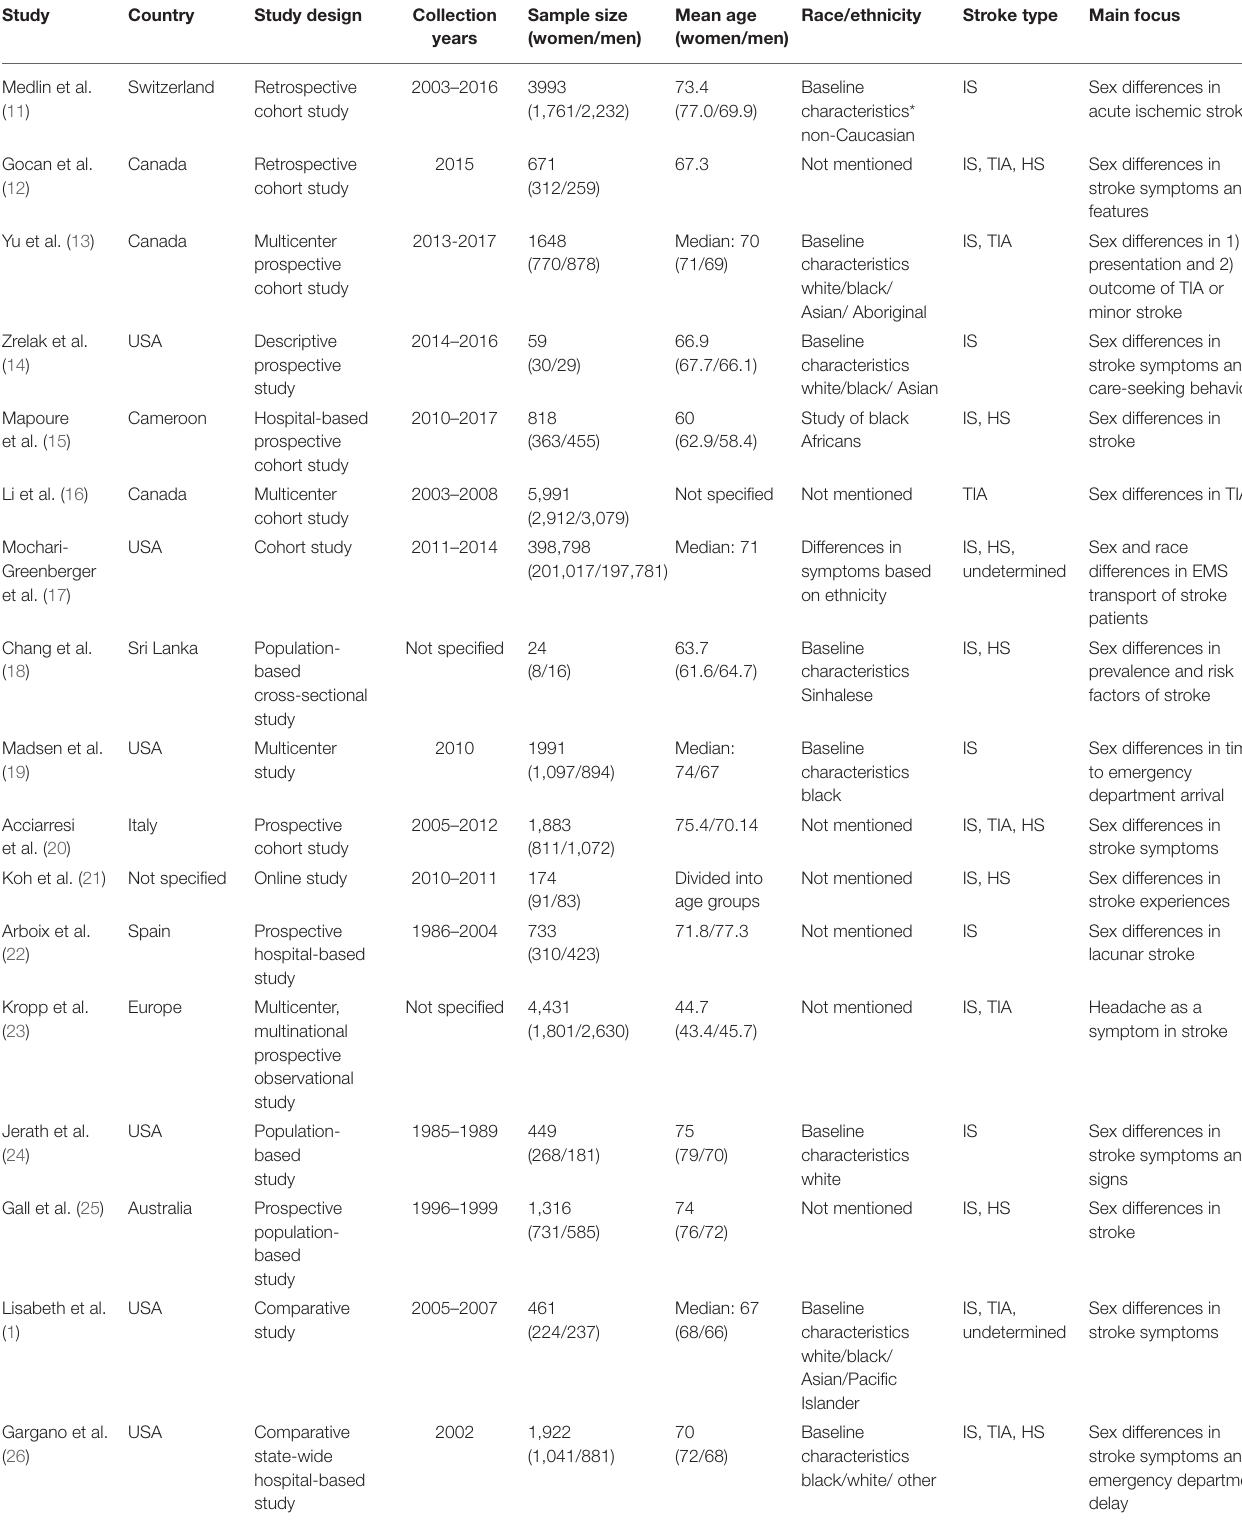
TABLE 1 | Baseline characteristics of all included